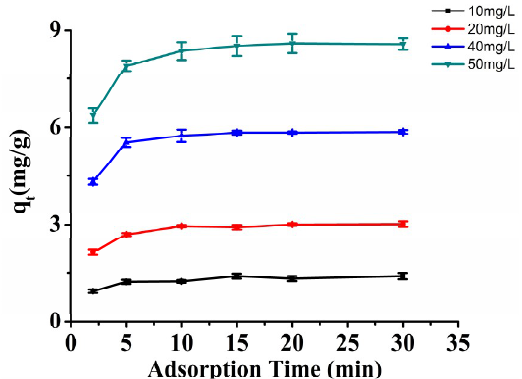
Figure 7. The influence of different initial concentration on the adsorption. A mass of 50 mg adsorbents in 10.0 mL solution; 34 mmol/L PBS, pH 7.0; 25 °C.